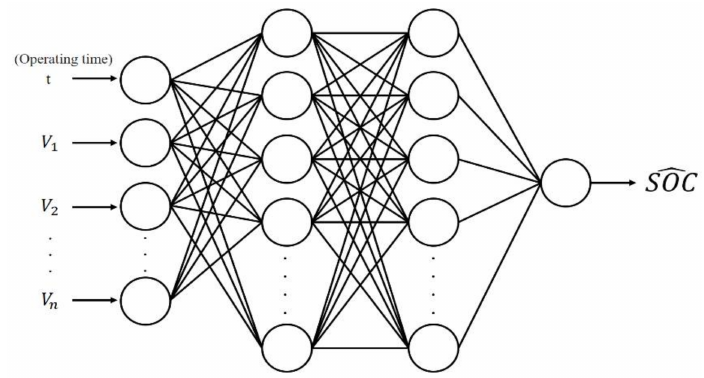
Figure 10. MNN structure for the SOC estimation model.